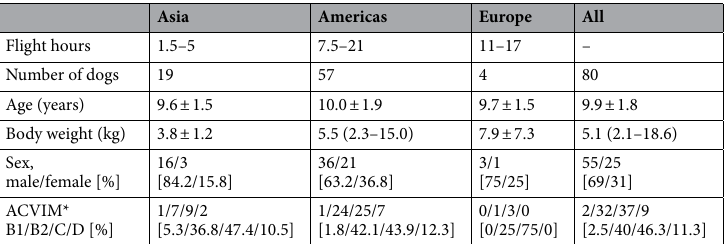
Table 1. Profile of dogs grouped by regions of their destination. The Shapiro–Wilk test was used to confirm normal distribution. p ≧ 0.05 was considered a normal distribution. *ACVIM, classification based on